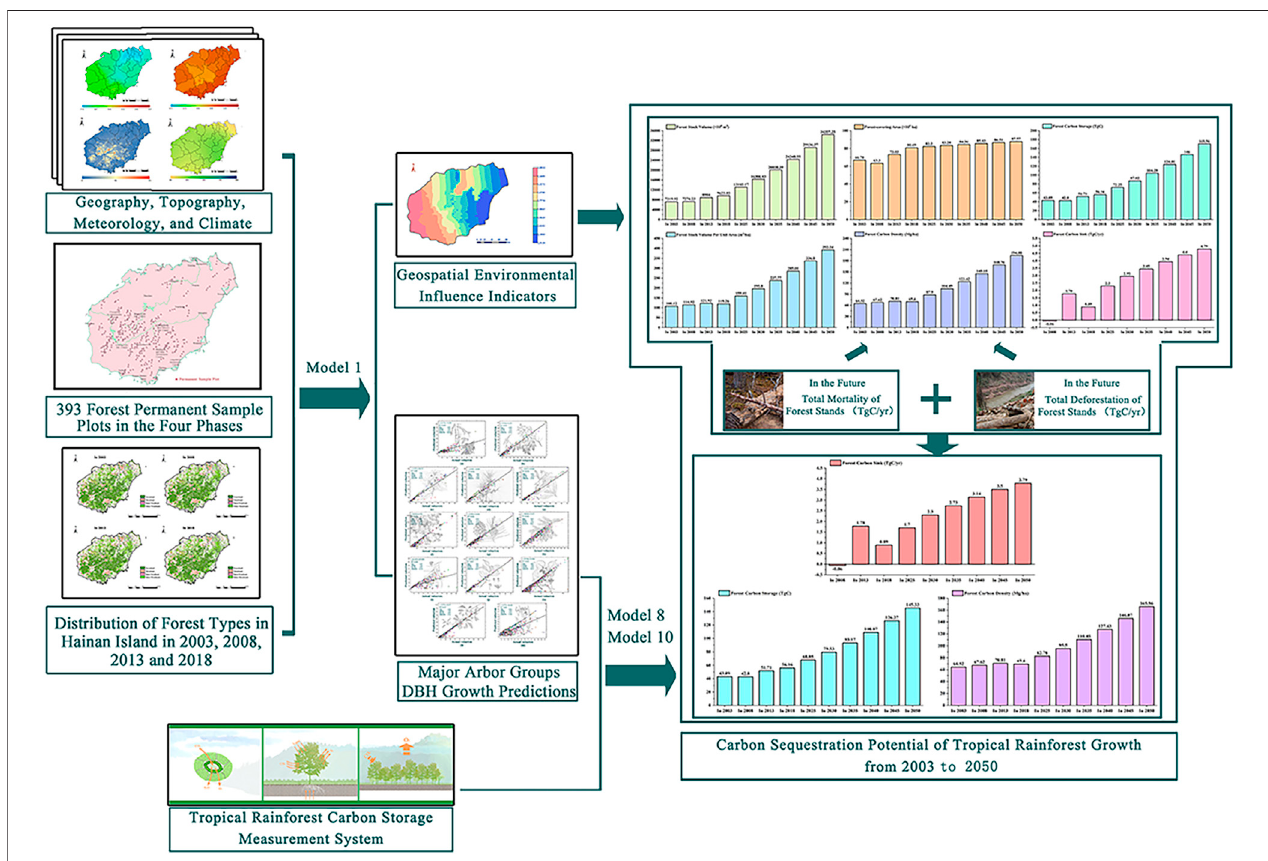
FIGURE 1 | Technology road